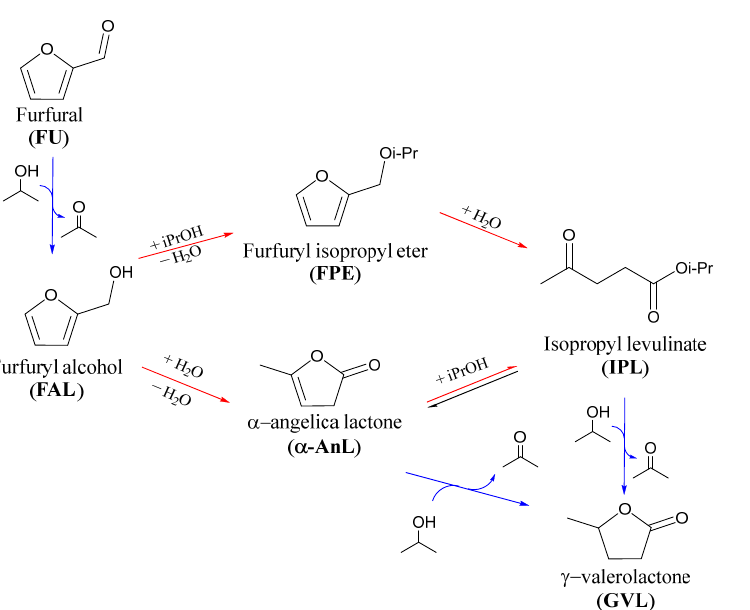
Figure 1. Reaction scheme for the synthesis of γ -valerolactone from furfural. The blue arrows indicate Lewis acidity-catalyzed pathways while the red arrows indicate Brønsted acidity-catalyzed pathways.